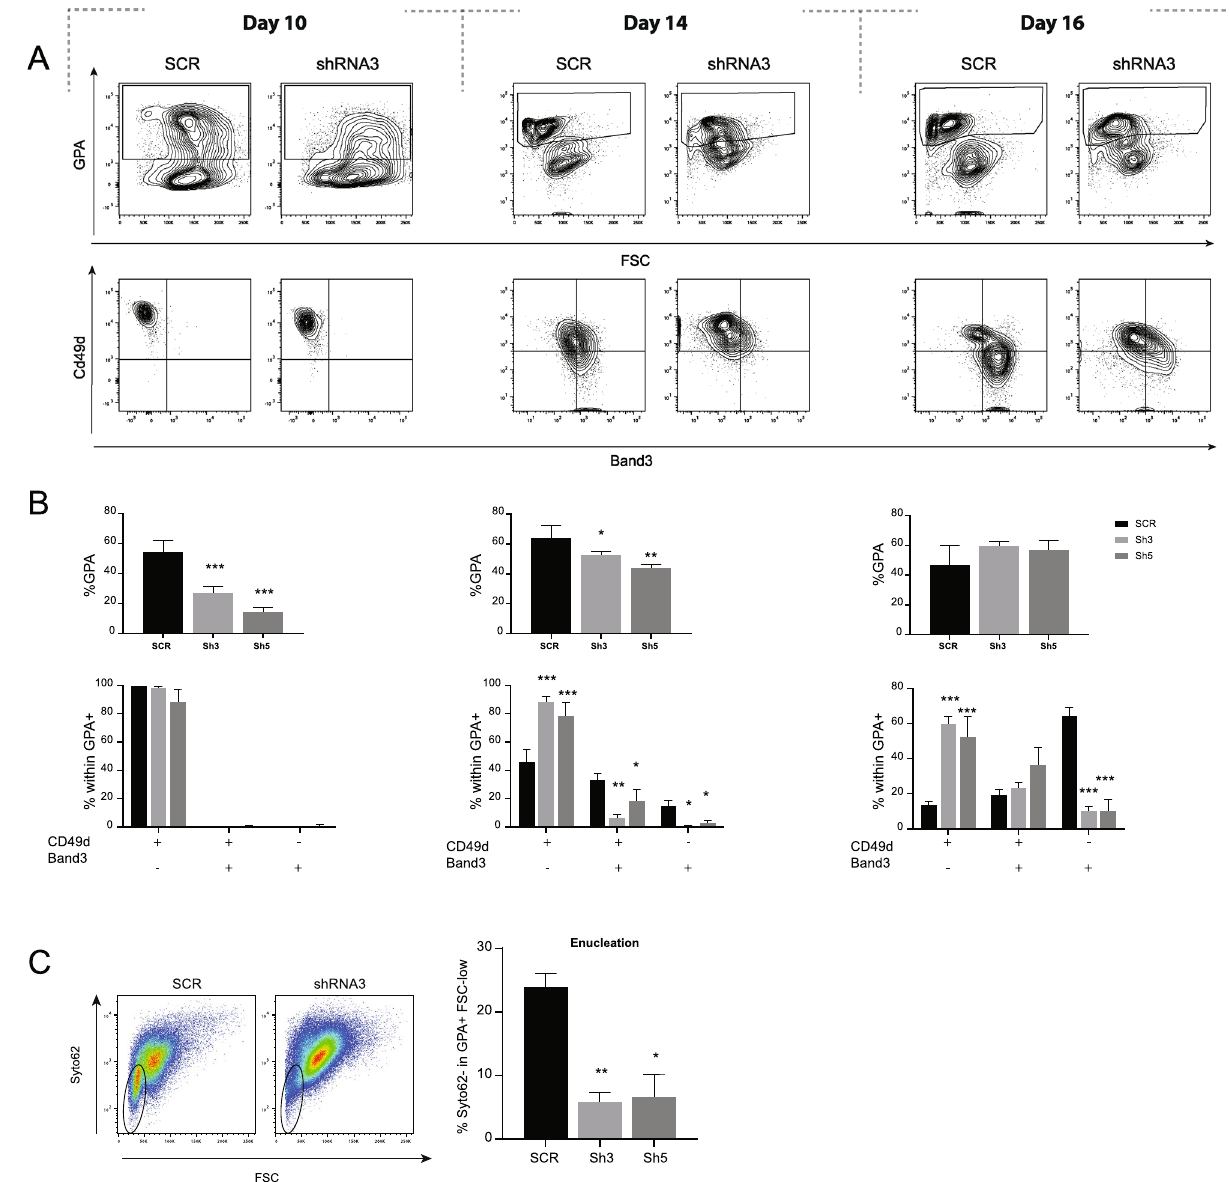
Figure 3. Decreased expression of PGC1β in CB derived CD34 + cells results in perturbed formation of early erythroid progenitors and impaired enucleation. ( A ) Representative plots and ( B ) quantification of flow cytometry analysis of GPA (top) and CD49d/Band3 (bottom) on day 10, 14 and 16 of CB derived CD34 + erythroid in vitro differentiation (n = 4). ( C ) Representative plots (left) and quantification (right) of enucleation efficiency based on Syto62 nucleic acid stain within mature GPA + cells (n = 4). Data is presented as mean ± SEM (*P ≤ 0.05, **P ≤ 0.01, ***P ≤